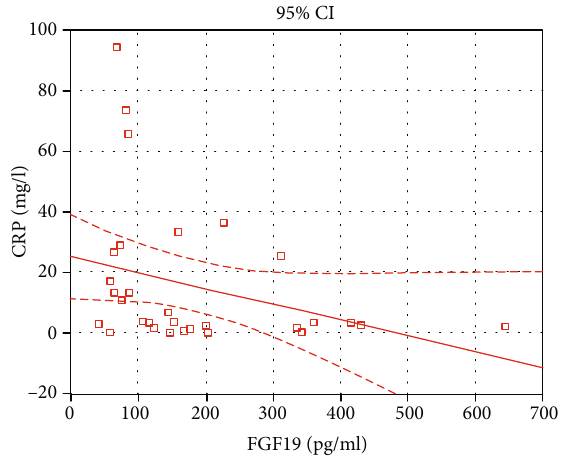
Figure 3: Correlation between serum FGF19 and serum CRP levels in ulcerative colitis. The inverse correlation between serum FGF19 and serum CRP levels was observed in UC patients ( n = 31 ) ( R = – 0 : 36 , p = 0 : 045